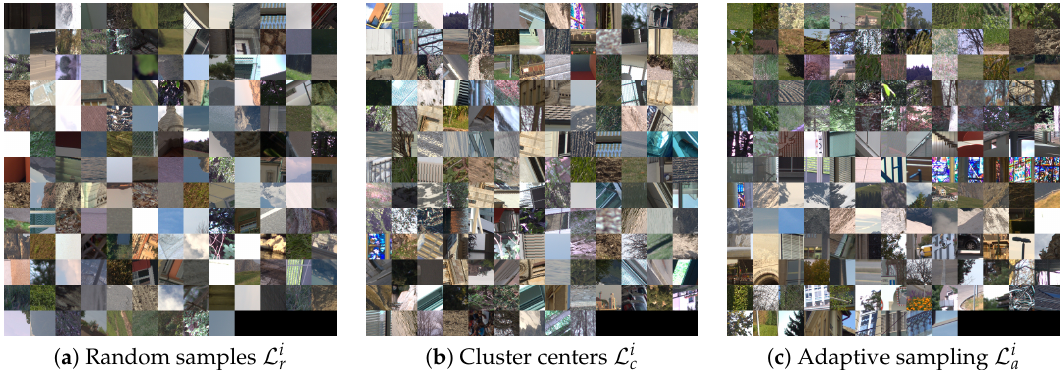
Figure 6. Examples of RGB patches from each type of dataset. Random sampling results in many smooth patches, while clustering and adaptive sampling select more textured patches for more informed